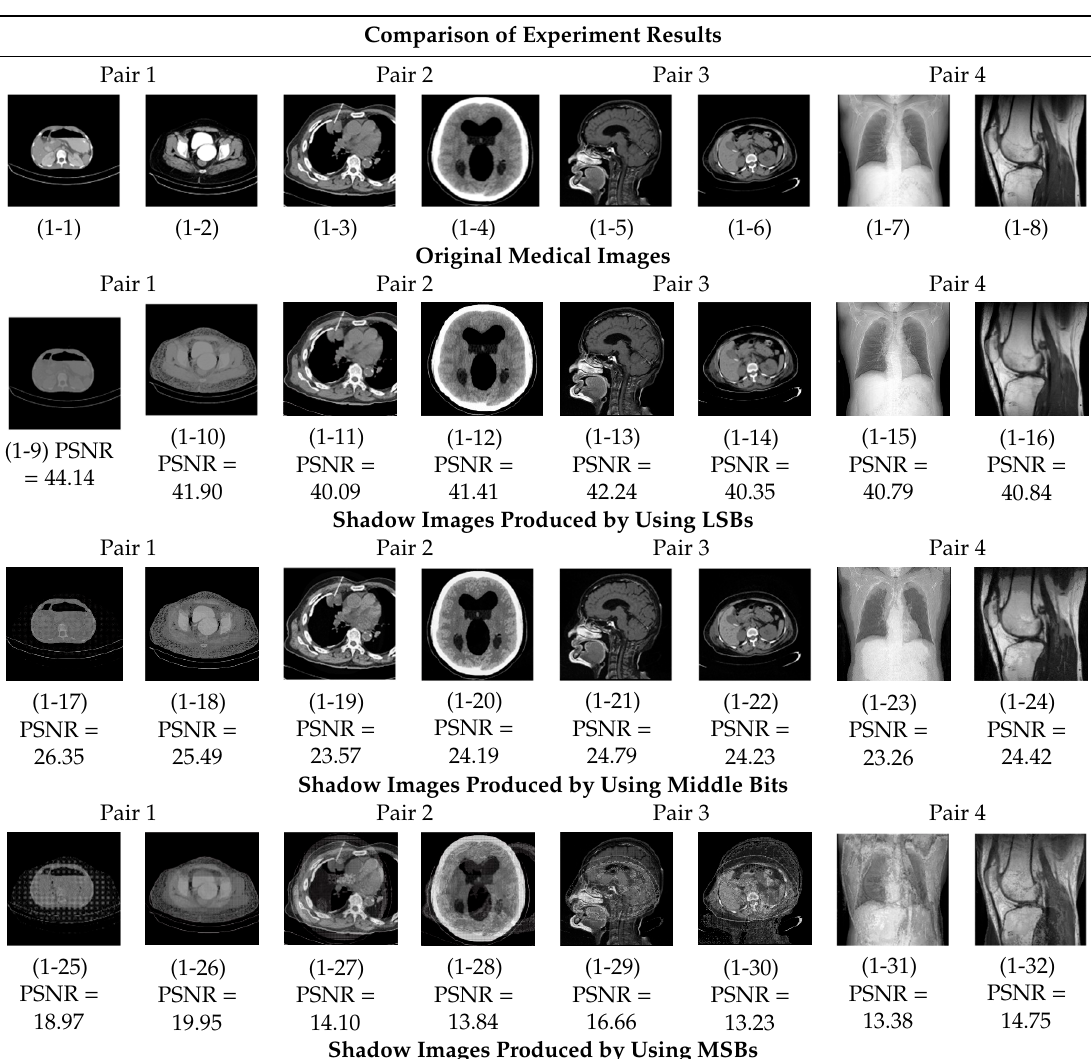
Table 1. Experimental result on medical images using (7,4) Hamming code.